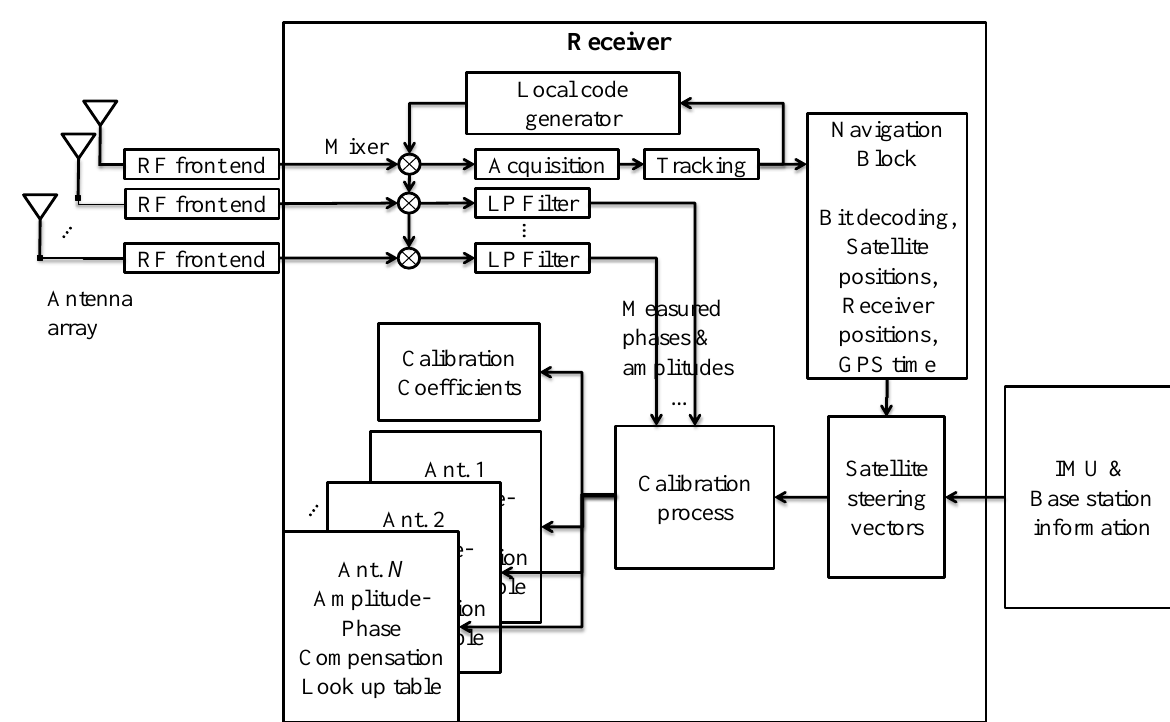
Figure 2. Multi-antenna receiver structure in the calibration